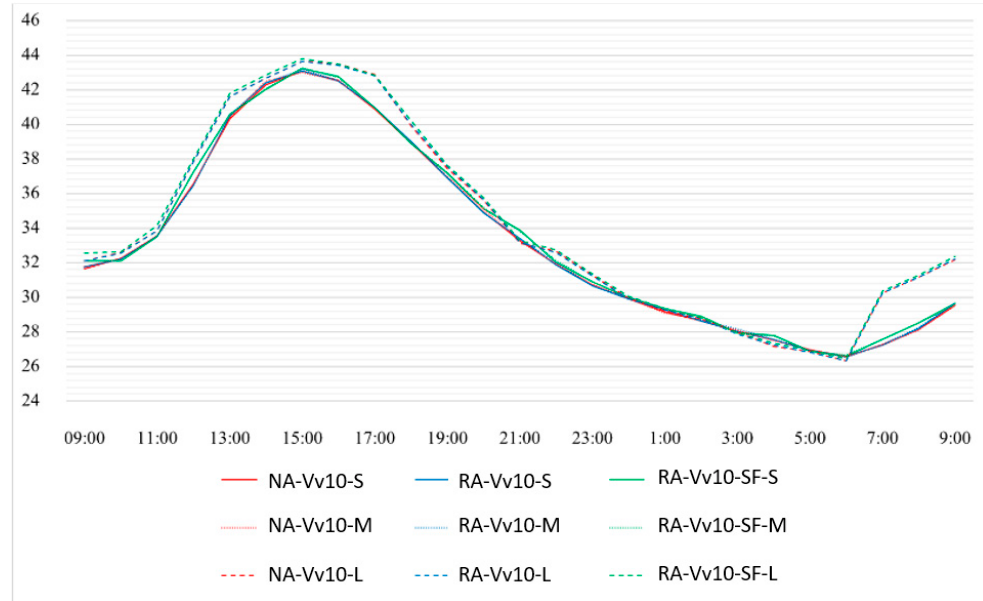
Figure 8. Variation of temperature in specimens with a 10% air void ratio.